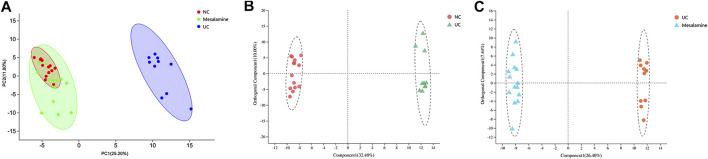
PCA and OPLS-DA plots among groups. (A) PCA score plots of NC, UC and mesalamine groups, red dots represented NC group, green dots represented mesalamine group and blue dots represented UC group. (B) OPLS-DA score plots of NC and UC groups, red dots represented NC group and green triangles represented UC group. (C) OPLS-DA score plots of UC and mesalamine groups, red dots represented UC group and blue triangles represented mesalamine group.